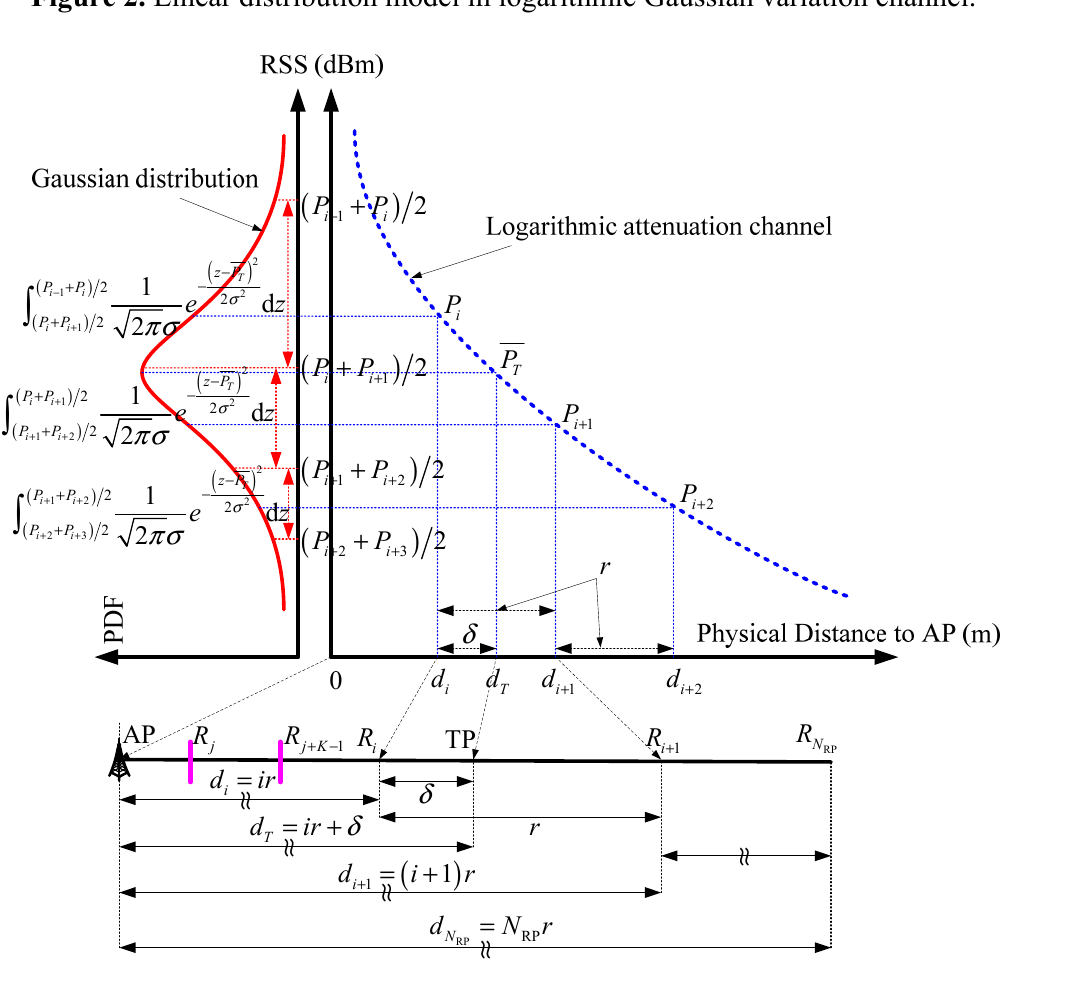
Figure 2. Linear distribution model in logarithmic Gaussian variation